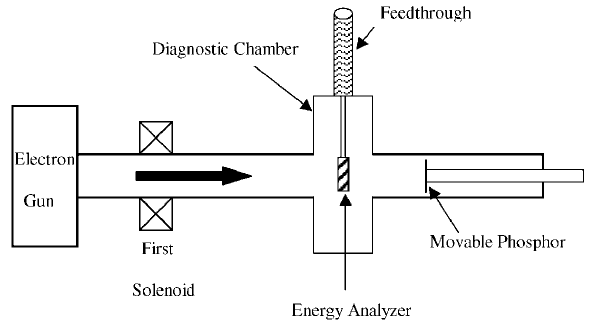
FIG. 11. Experimental setup for energy analyzer